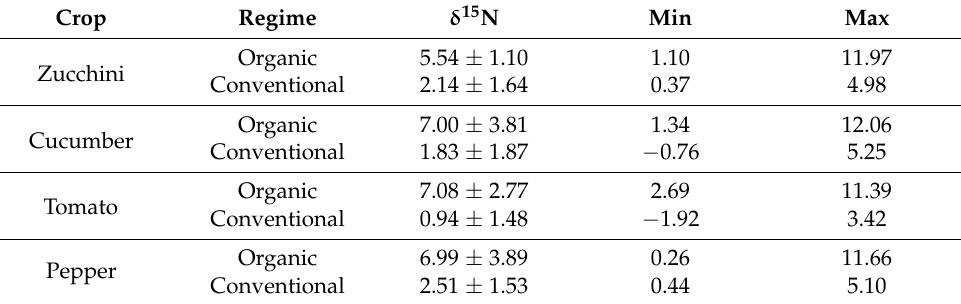
Table 2. Summarized data, including mean ± standard deviation, minimum, and maximum stable nitrogen isotope values of the different vegetables analysed from organic and conventional regimes.